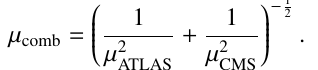
Fig. 4. Constraints on MUED parameter space. Purple and pink show regions ruled out by DM considerations. Gold denotes the region excluded by the Higgs search analysis presented here and also the existing LEP2 limit. Points between the blue hyper- boloids agree with LEP EW precision fits to a 95 %